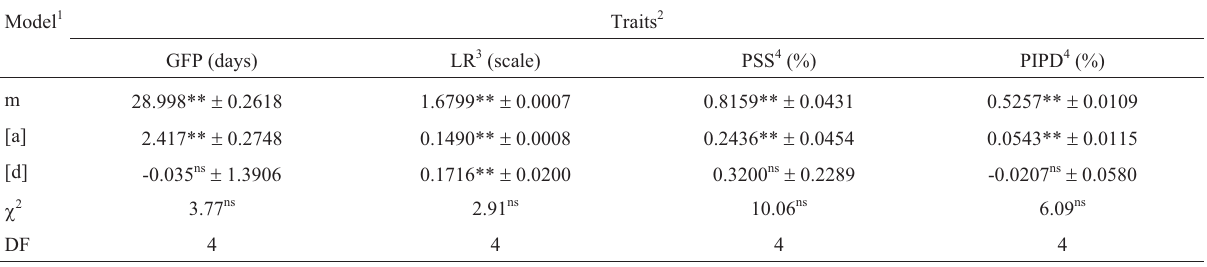
Table 3 - Genetic models adjusted to the means of the FT-Estrela (G1) and IAC-100 (G2) parent lines and their segregating populations F 2 , F 3:2 , BC 1 F 3:2 , BC 2 F 3:2 and F 4